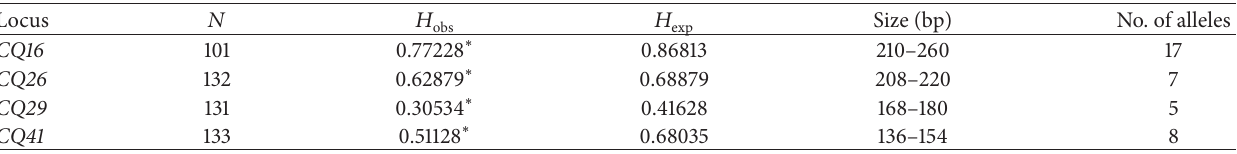
Table 2: Summary information of the four microsatellite loci averaged over the seven populations of Culex quinquefasciatus . The number of individuals genotyped ( 𝑁 ), observed and expected heterozygosities ( 𝐻 shown for each locus.